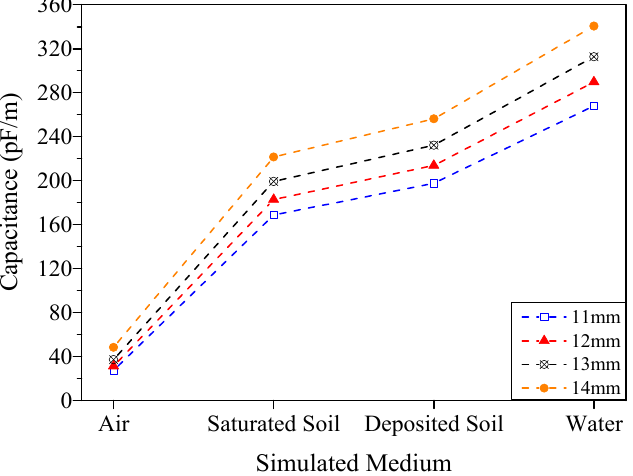
Figure 8. Capacitance values obtained for various simulated media for electrode lengths of 11 mm (rectangular mark), 12 mm (triangle mark), 13 mm (node mark) and 14 mm (filled dot mark).